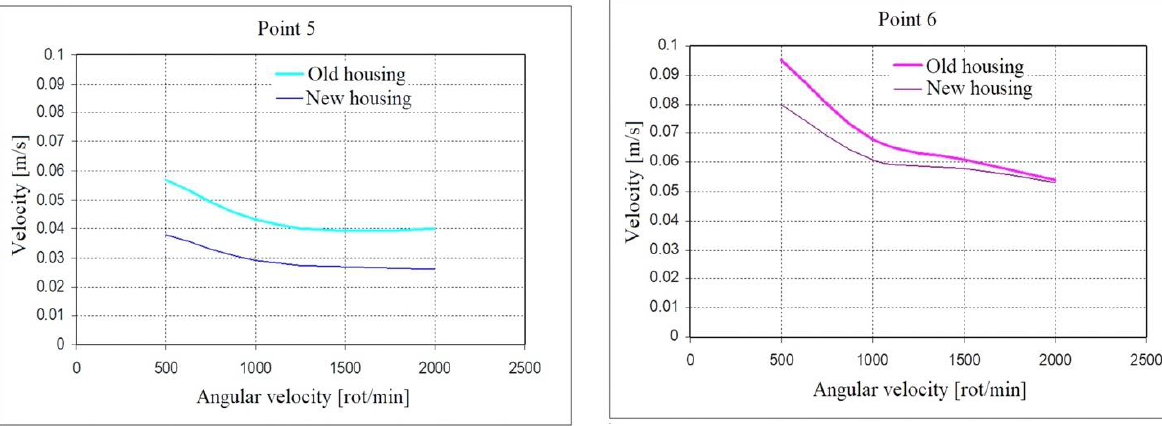
Figure 27. Displacements in measuring points 1 and 2 on the two summing boxes (old and new version).